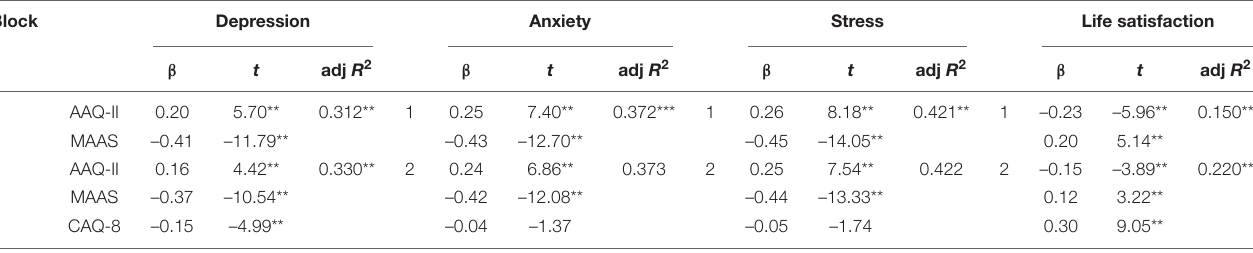
TABLE 5 | Hierarchical multiple regression predicting depression, anxiety, stress, and life satisfaction.